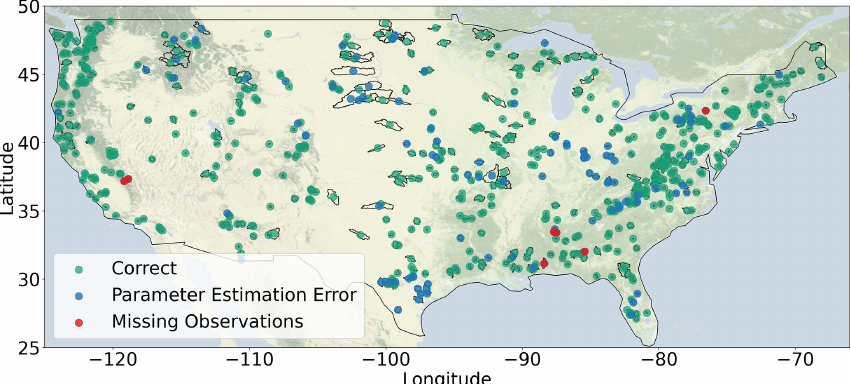
Figure 1. Basin locations of the CAMELS data set. The included basins are marked in green; blue shows the excluded basins due to parameter estimation errors and red shows the excluded basins due to missing streamflow observations. Basemap made with Natural